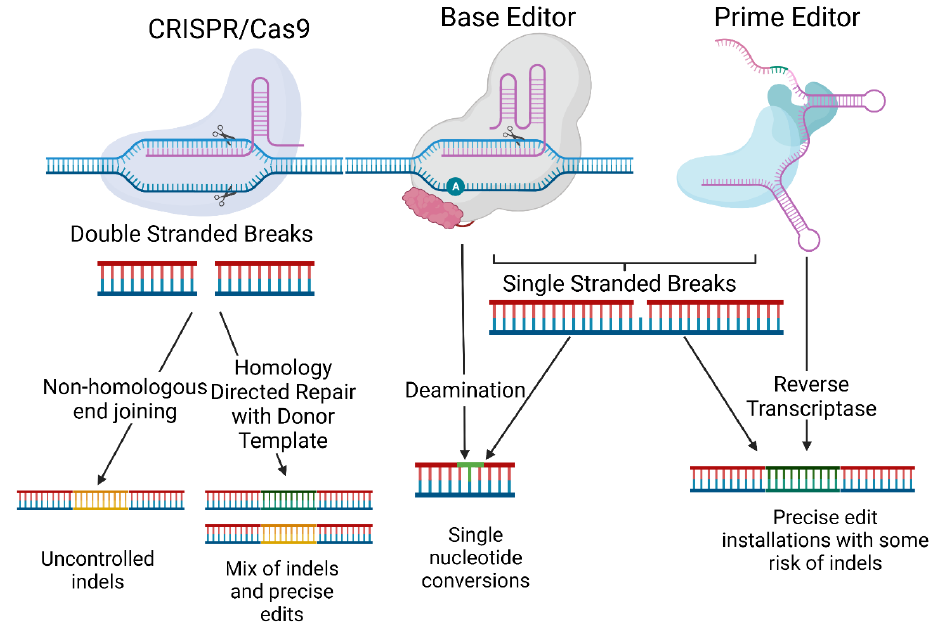
Figure 1. Comparison of CRISPR–Cas9, base editor and prime editor. CRISPR–Cas9 causes double- stranded breaks, resulting in uncontrolled indels when paired with non-homologous end joining. When used with a donor template, this can trigger the homology-directed repair pathway, resulting in a mix of indels and precise edits. Base editor and prime editor both generate single-stranded breaks. Base editor combines this with deamination and mismatch repair to generate single nucleotide conversions. Prime editor instead uses a reverse transcriptase to encode many possible types of precise edits. Figure was created in BioRender.